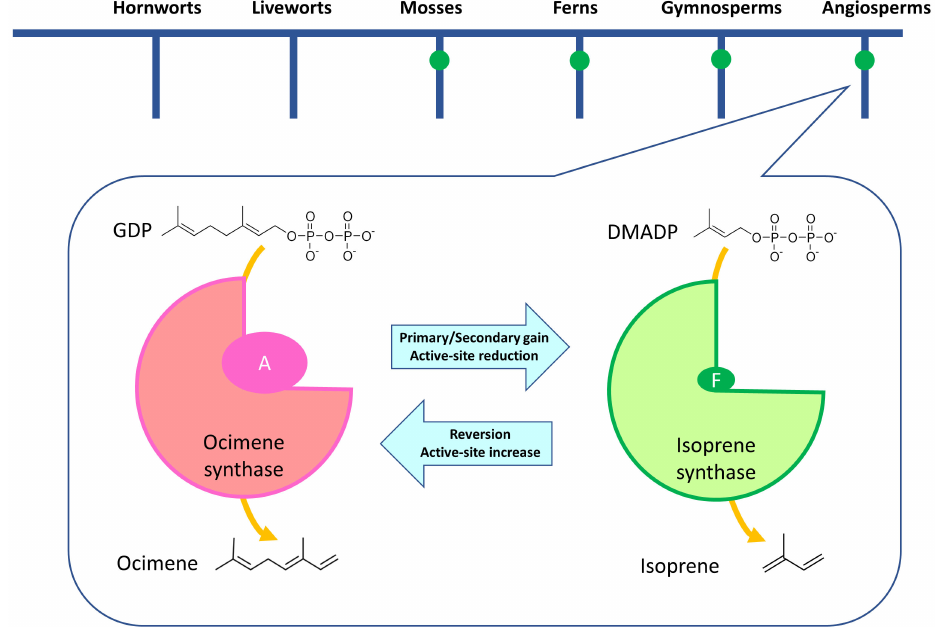
Figure 1. The capacity to emit isoprene (represented by green dots on the different evolutionary lineages) has evolved multiple times in higher plants and in their ancestors. In angiosperms, a model of gain and loss of isoprene synthase function has been proposed [24]. Figure inset readapted from [24] represents the specific step. Ocimene synthase converts geranyl pyrophosphate (GDP) in ocimene whereas isoprene synthase is able to generate isoprene using dimethylallyl pyrophosphate (DMADP) as a precursor. Which enzyme is effectively used depends on the size of the active site, which is increased in the case of ocimene synthase due to the presence of alanine (A) and reduced in the case of isoprene synthase due to the presence of phenylalanine (F). Substitution of A with F has repeatedly occurred over evolution leading to primary gain of isoprene emission capacity, but reversion from F to A has also occurred repeatedly, leading to loss of isoprene emission